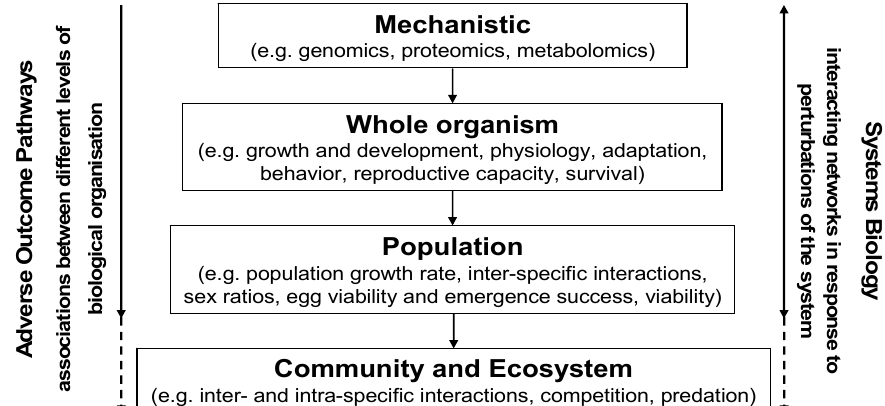
Figure 5. A suite of assessment types may be used to investigate links or associations across different levels of biological organization, as well as the interactions amongst networks in response to perturbations within a biological